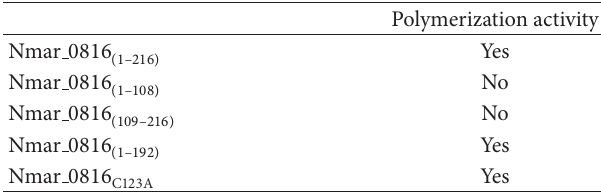
Table 1: Summary on the domain analysis of the Nmar 0816 (1–216 aa) protein for its polymerization activity in